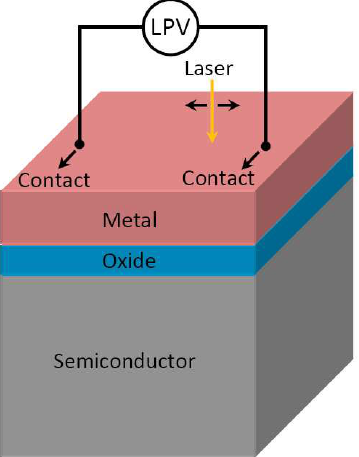
Figure 1. Diagram of LPV measurement in a MOS structure on metal